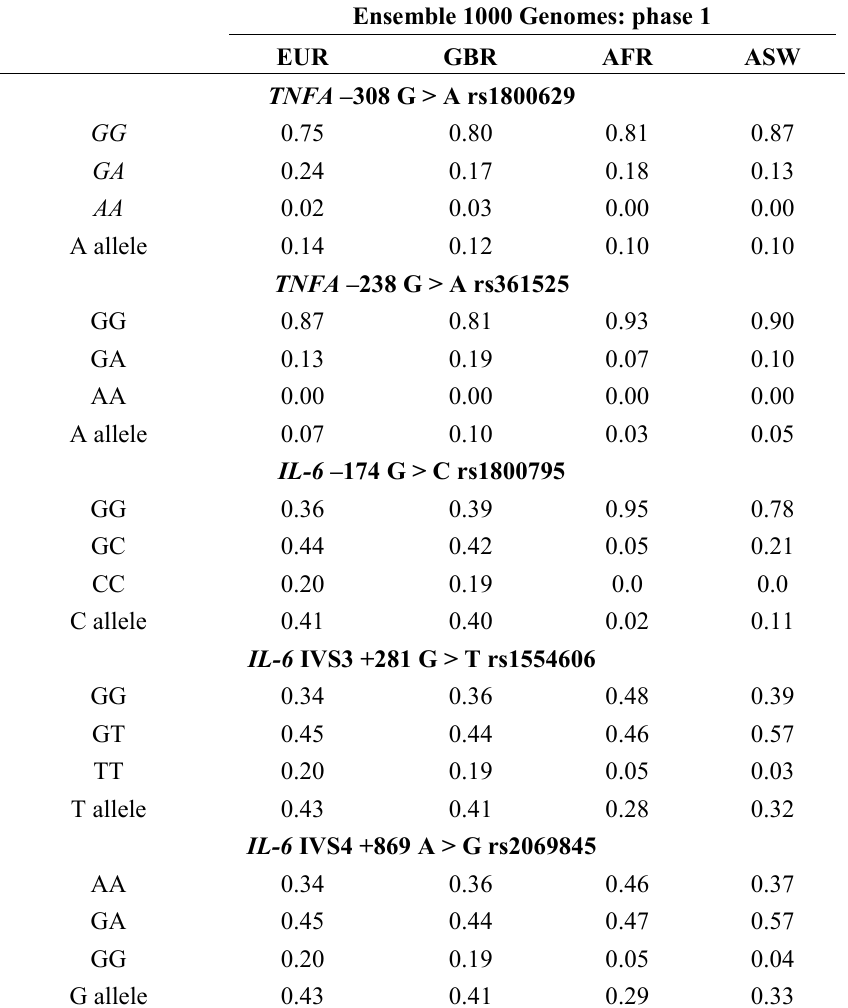
Table 4. TNFA and IL-6 genotype and minor allele